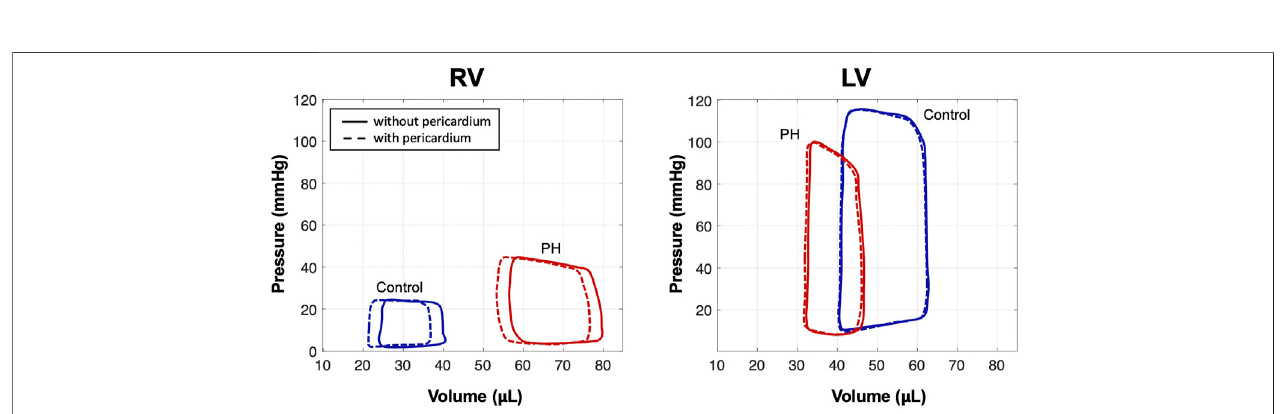
FIGURE4| Pressure-volume loopsfromsimulationsofcontrolandPHheartswithand withoutpericardium.Simulationspredictedanotableincrease inEDVinthe RV after removal of the pericardium; EDV in the LV remained nearly constant.